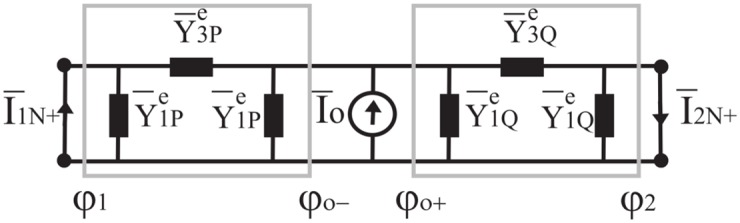
The equivalent network in t plane relevant to the problem described in Fig 10.